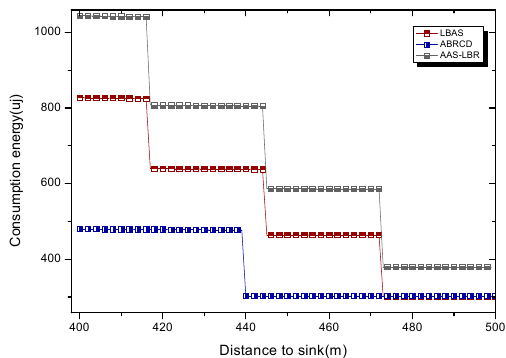
Figure 33. Energy consumption of nodes 400–500 m away from sink under 𝑇 = 100 and 𝑟 = 28 m .